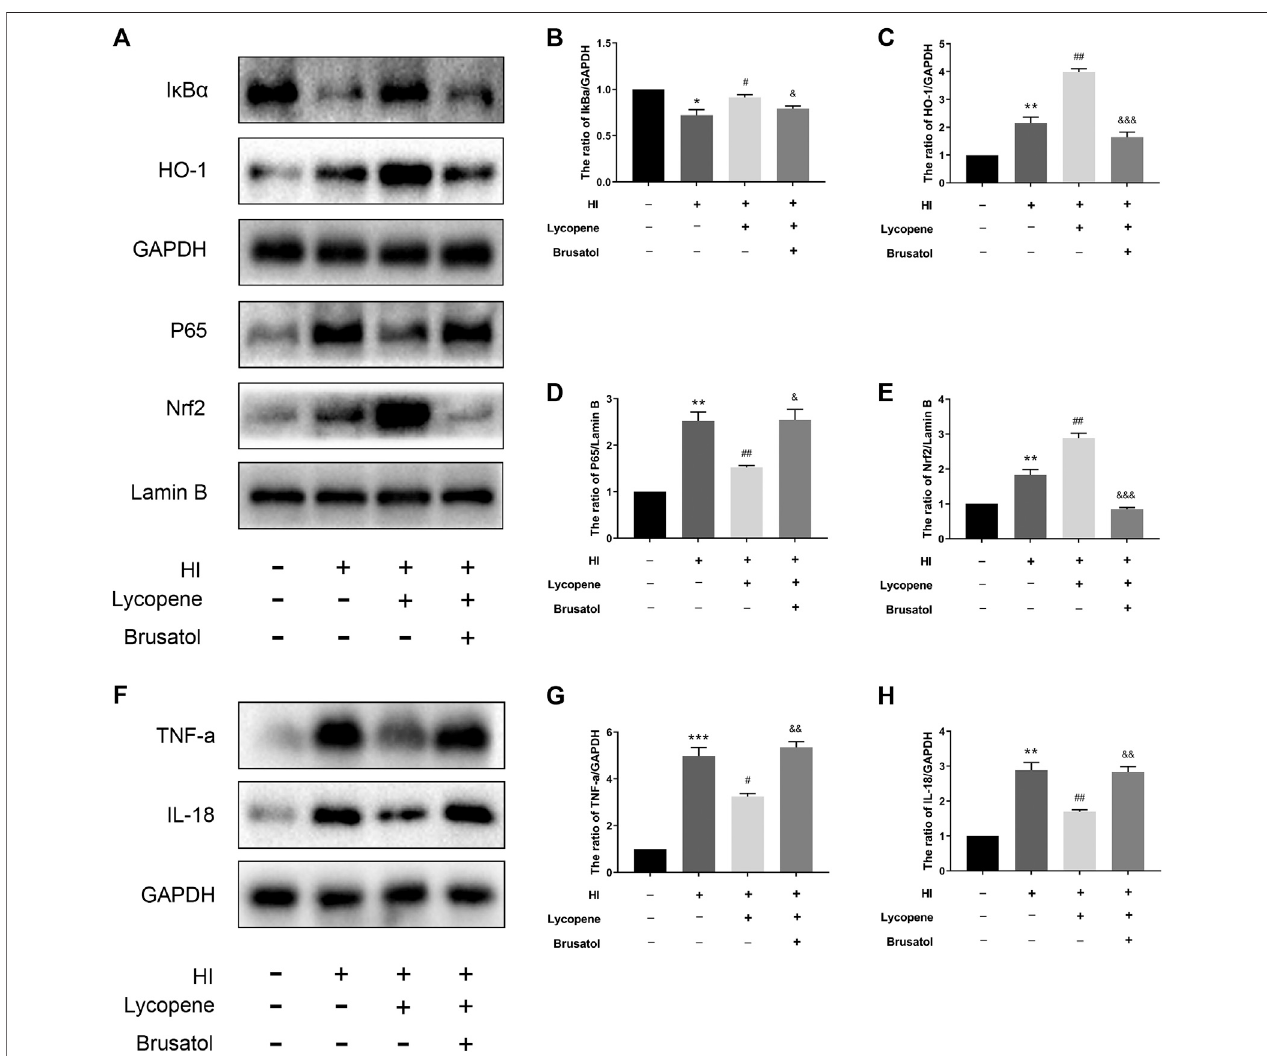
FIGURE 3 | Treatment with Lycopene (Lyc) exerted neuroprotection via the Nrf2/NF- κ B signaling pathway after hypoxic-ischemic brain injury in neonatal rats. (A) The protein levels of I κ B α , HO-1, P65, Nrf2, tumor necrosis factor α (TNF- α ) and interleukin (IL)-18 were detected by Western blot 24 h after the HI injury. (B – H) Quantitative analysis of I κ B α , HO-1, P65, Nrf2, TNF- α and IL-18. * p < 0.05, ** p < 0.01 and *** p < 0.001 vs. the sham group; # p < 0.05 and ## p < 0.01 vs. the HI group; & p < 0.05, && p < 0.01 and &&& p < 0.001 vs. the HI + Lyc group. All data are presented as mean ± SEM, n (cid:2) 3.